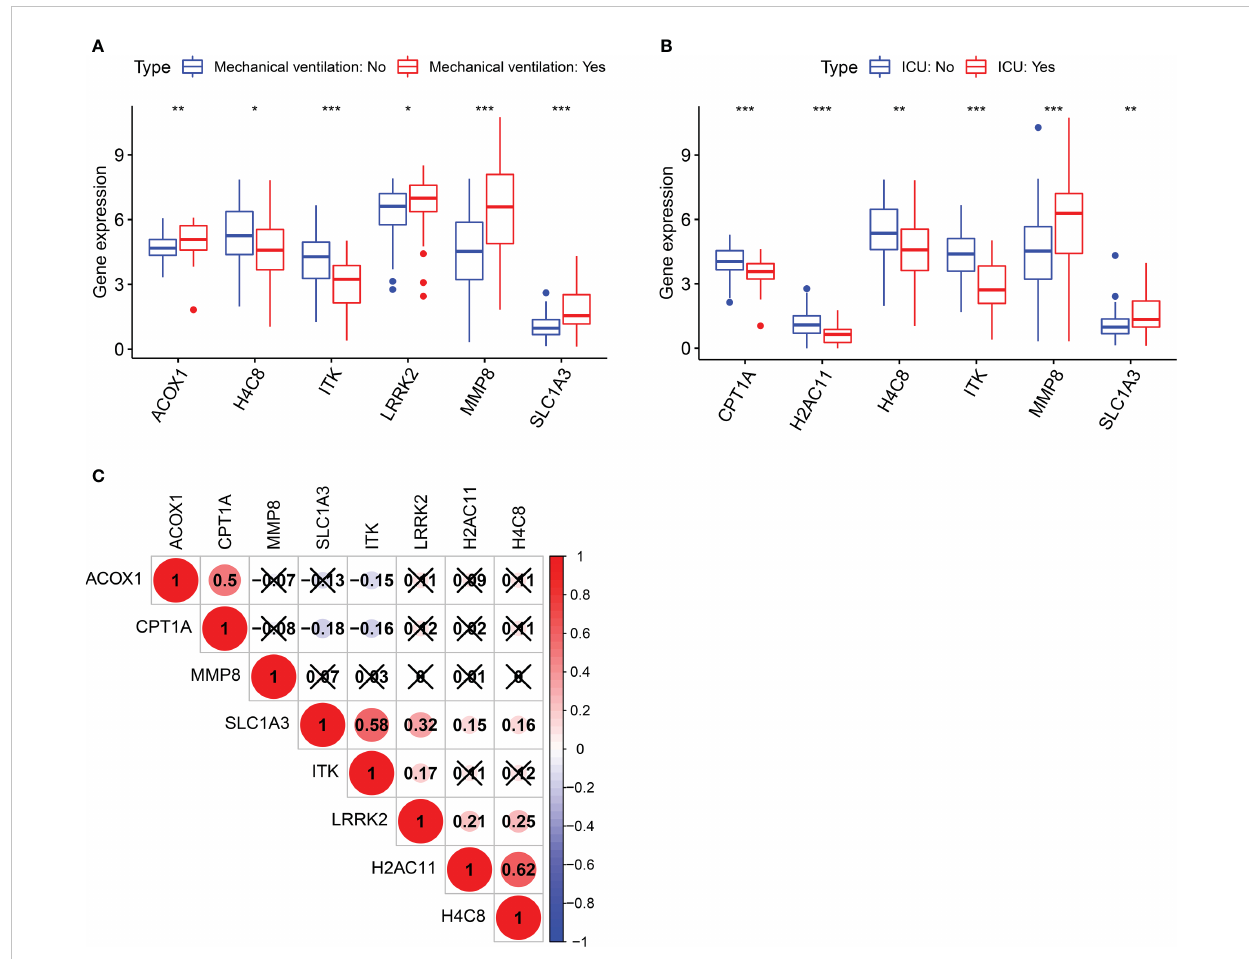
FIGURE 4 Clinical signi fi cance of target genes in COVID-19 patients. (A) Boxplot of target genes associated with mechanical ventilation. (B) Boxplot of target genes associated with ICU admission. (C) The correlation analysis between genes after screening. * p < 0.05, ** p < 0.01, *** p <